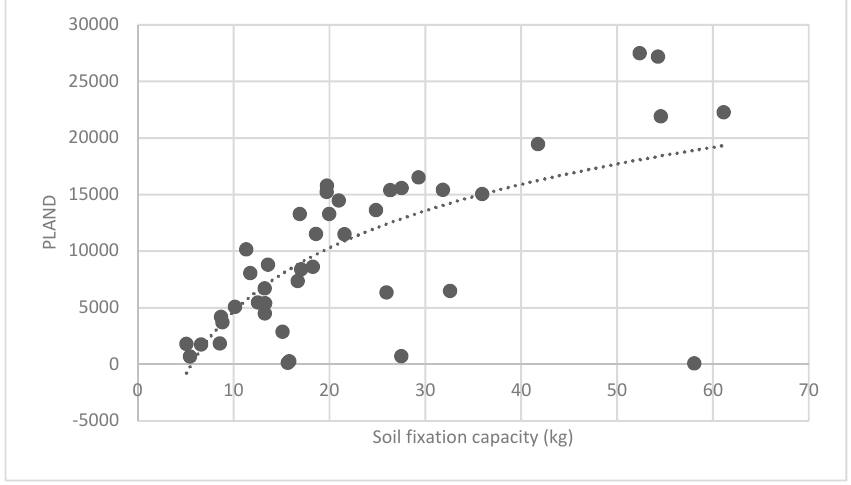
Figure 20. Association between forest land PLAND index and soil fixation capacity.